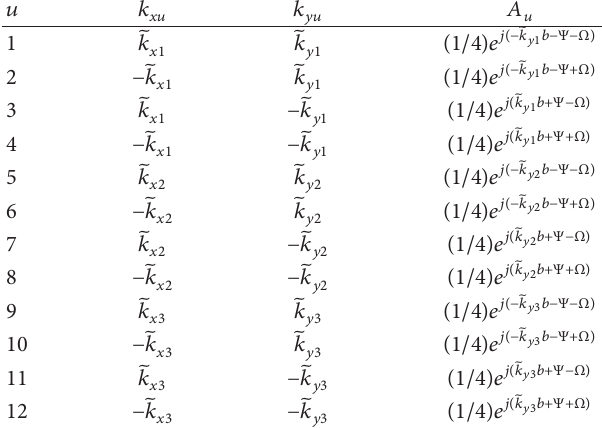
Table 2: Values of parameters 𝑘 𝑥𝑢 , 𝑘 𝑦𝑢 , and 𝐴 𝑢 , where the parame- ̃𝑘 ̃𝑘 ters denoted as 𝑦 1,2,3 and 𝑥 1,2,3 are the ones described immediately after (4a)–(4d), and Ψ and Ω are defined in Table 3.